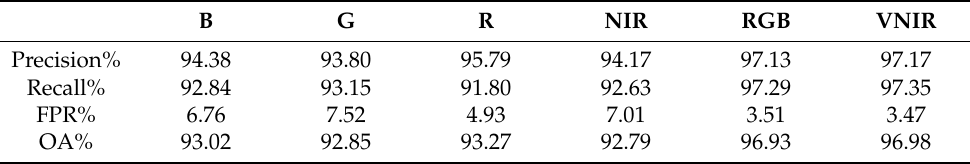
Figure 7. The detection results under different bands. ( a ) The original RGB image; ( b ) detection result of the B band; ( c ) detection result of the G band; ( d ) detection result of the R band; ( e ) detection result of the NIR band; ( f ) detection result of the RGB bands; ( g ) detection result of the VNIR bands. The coordinates of ( a ) are 109.0E and 34.4N. Table 4. Assessment of the detection results under different bands on the test